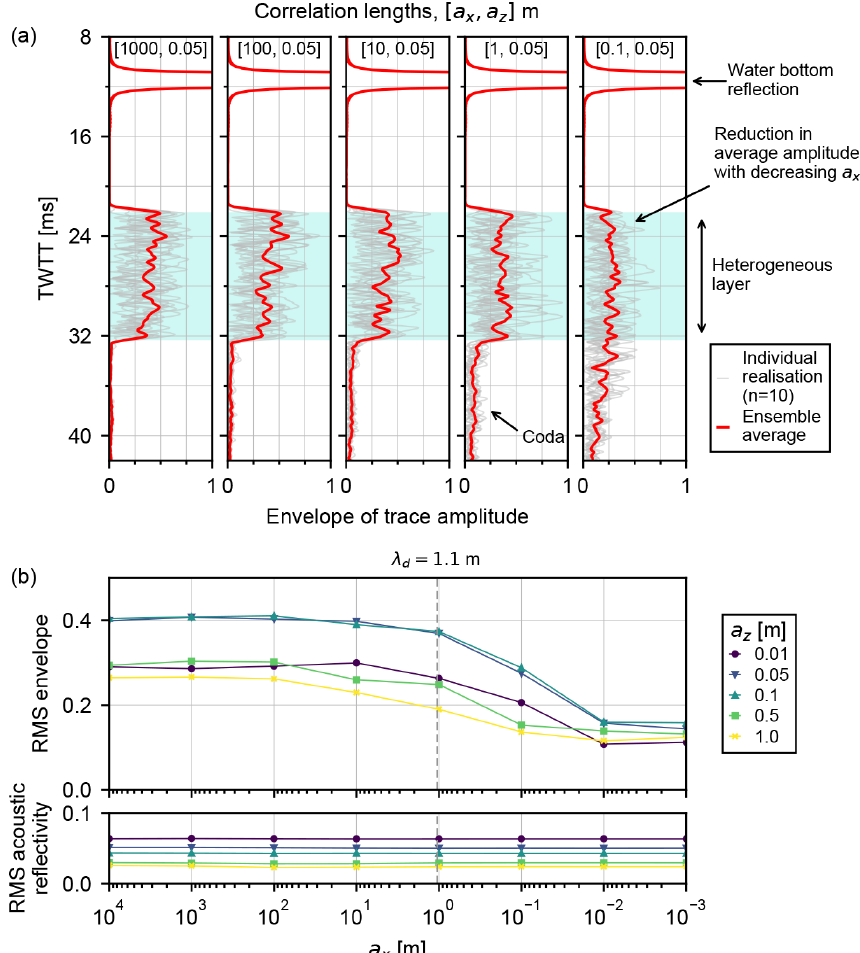
Figure 4. Single-source synthetic experiment results. (a) Envelope of trace amplitude for n = 10 multiple realisations (gray) and the rms envelope of all realisations (red) for fixed vertical correlation length a z = 0 . 05m and lateral correlation lengths a x = { 1000 , 100 , 10 , 1 , 0 . 1 } m (from left to right). The two-way travel time (TWTT) extent of the heterogeneous layer is shaded in blue. (b) The rms envelope within the heterogeneous zone against lateral correlation length, a x , grouped by vertical correlation length, a z (top). The rms vertical-incidence acoustic reflectivity within the heterogeneous zone (bottom). λ d shows the dominant wavelength of the 1.5kHz seismic source in the sediment